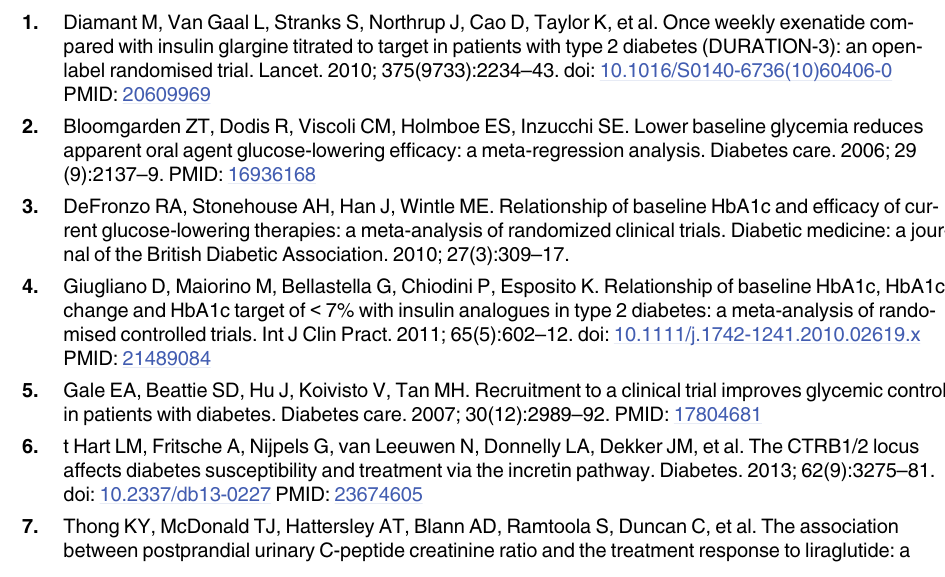
S3 Table. A: The effect of baseline HbA1c adjustment on the association between baseline covariates and HbA1c change after sulfonylurea therapy (GoDARTS). β = linear regression β coefficient, standardised for baseline covariates to represent HbA1c response difference (as a percentage of baseline HbA1c) for a 1 standard deviation increase in baseline covariate. A posi- tive β suggests a smaller HbA1c reduction with a higher value of the baseline covariate. Num- bers in brackets represent the 95% confidence interval around β . B: The association between baseline covariates and HbA1c change after Sulfonylurea therapy, expressed as a percent- age of baseline HbA1c. B = linear regression β coefficient, standardised for baseline covariates to represent HbA1c response difference (as a percentage of baseline HbA1c) for a 1 standard deviation increase in baseline covariate. A positive β suggests a smaller HbA1c reduction with a higher value of the baseline